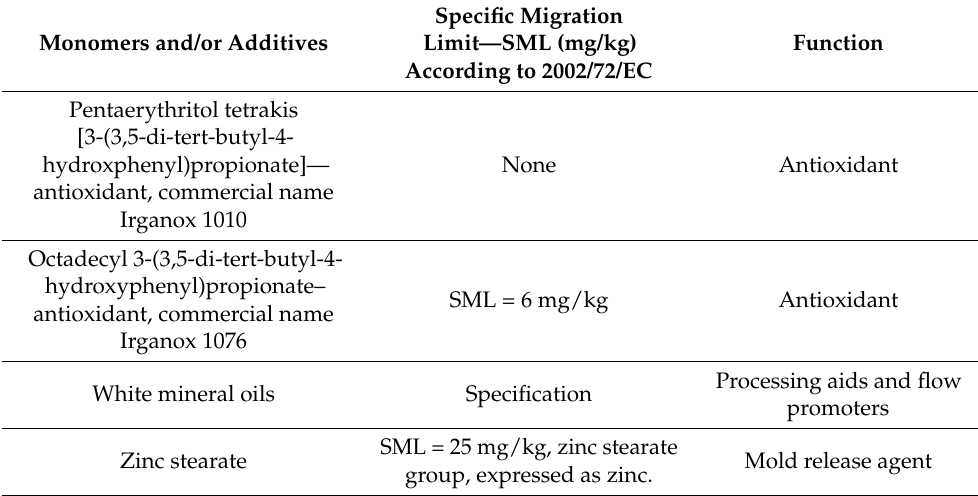
Table 10. Most common additives in PS manufacturing, describing their functions and specific migration limit (SML) in food or food simulants. Adapted from Table 1 in reference [173]. Specific Migration Monomers and/or Additives Limit—SML (mg/kg) Function According to 2002/72/EC Pentaerythritol tetrakis